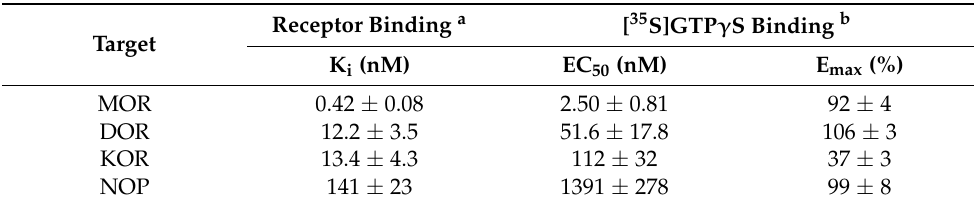
Table 1. Binding affinities and functional activities of KGNOP1 to the human MOR, DOR, KOR, and NOP